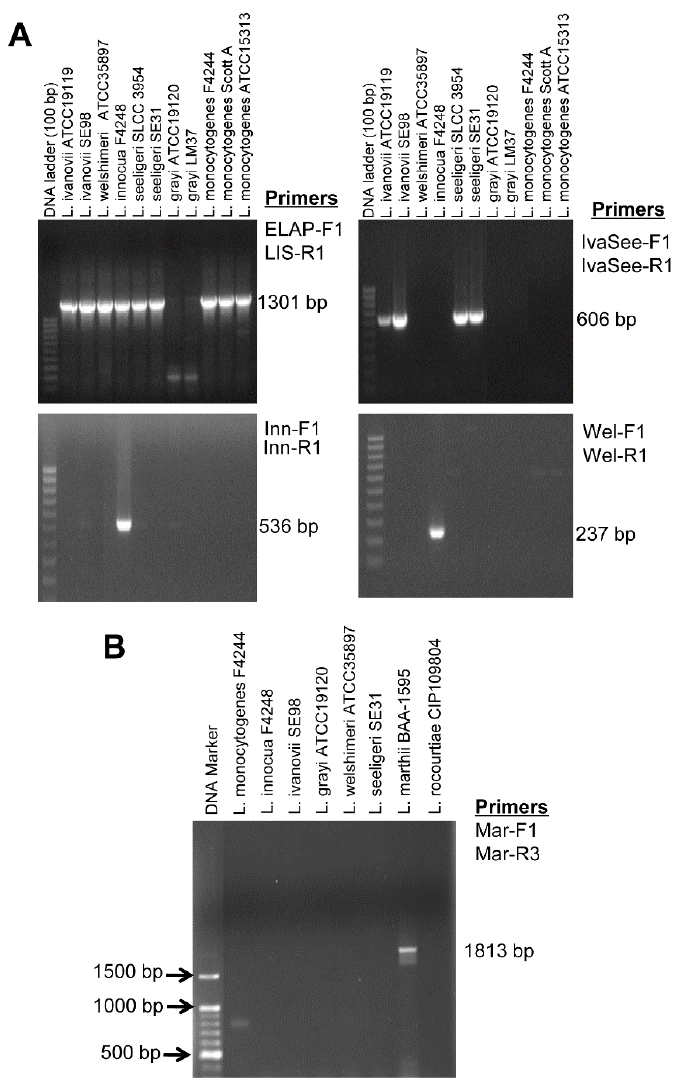
Figure 2. Representative agarose gel showing PCR amplification of selected Listeria species by using species-specific primers. ( A ) PCR results based on the species of Listeria sensu stricto -specific, and L. innocua -, L. ivanovii - and L. seeligeri - and L. welshimeri -specific primers. ( B ) PCR result using L. marthii -specific